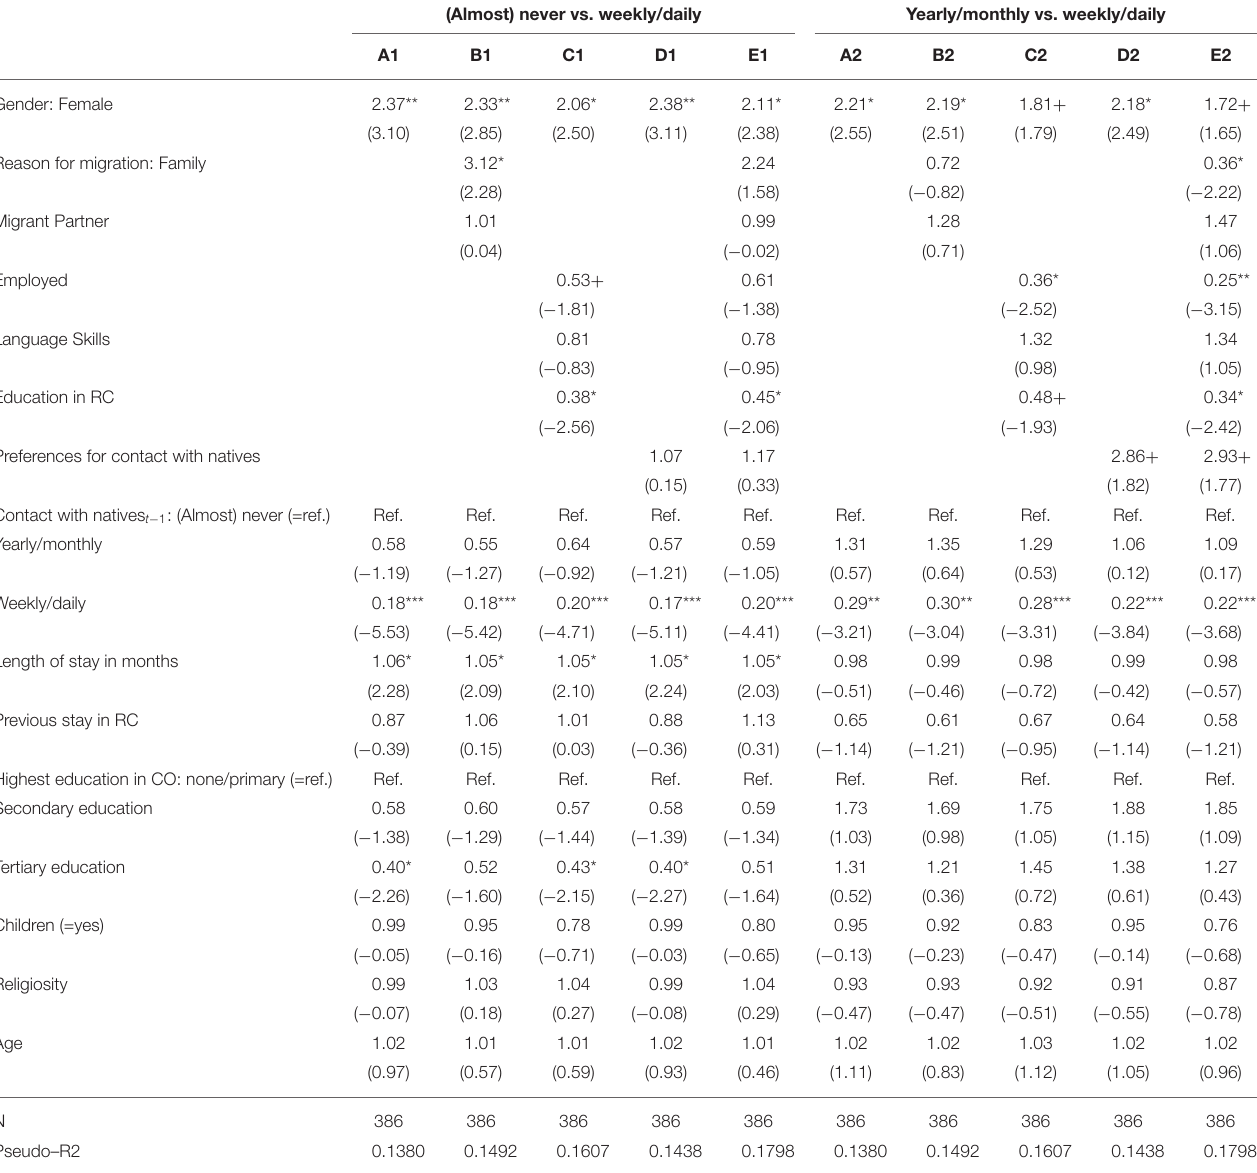
TABLE 2 | Multinominal Logistic Regression Analysis (Relative Risk Ratio): Impact of gender, family influence, opportunity, and preferences on time spend with natives. (Almost) never vs. weekly/daily